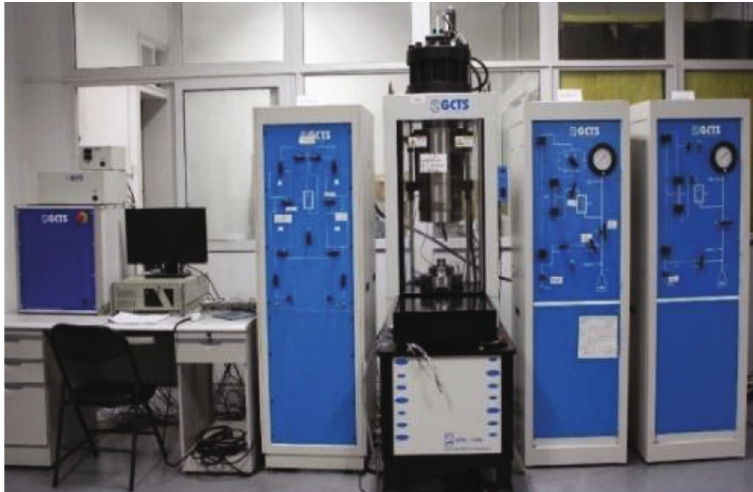
Figure 1: GCTS test system.